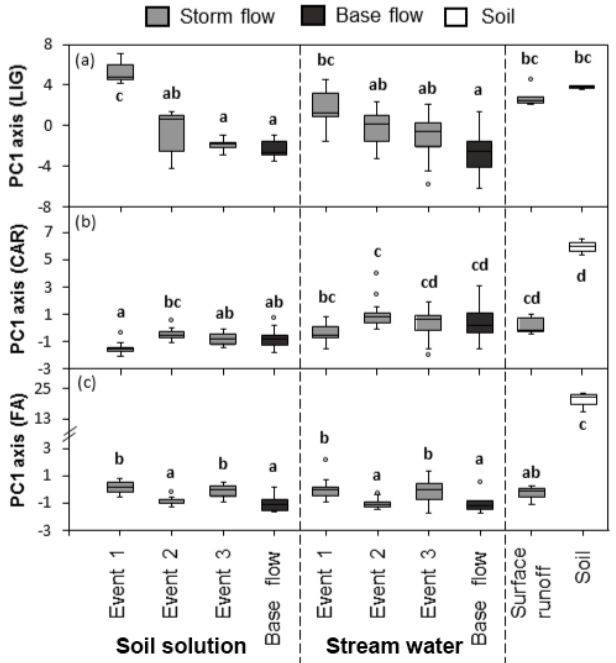
Figure 4. Coordinate on PC1 axis from (a) LIG, (b) CAR and (c) FA molecular distribution PCA analysis for soil, surface runoff, stream water and soil solution during storm-flow and base-flow. Letters not shared across box plots indicate significant mean dif- ferences using Dunn’s test of multiple comparison. PC1 represents 37.4% of the variance for lignin PCA, 62.0% of the variance for carbohydrates PCA and 39.0% of the variance for fatty acids